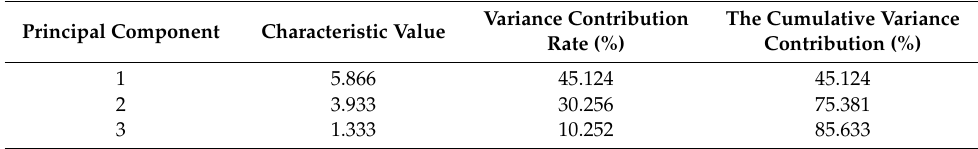
Table 1. Eigenvalue and accumulative contribution rate of the postharvest quality evaluation of Majiayou pomelo (MP).